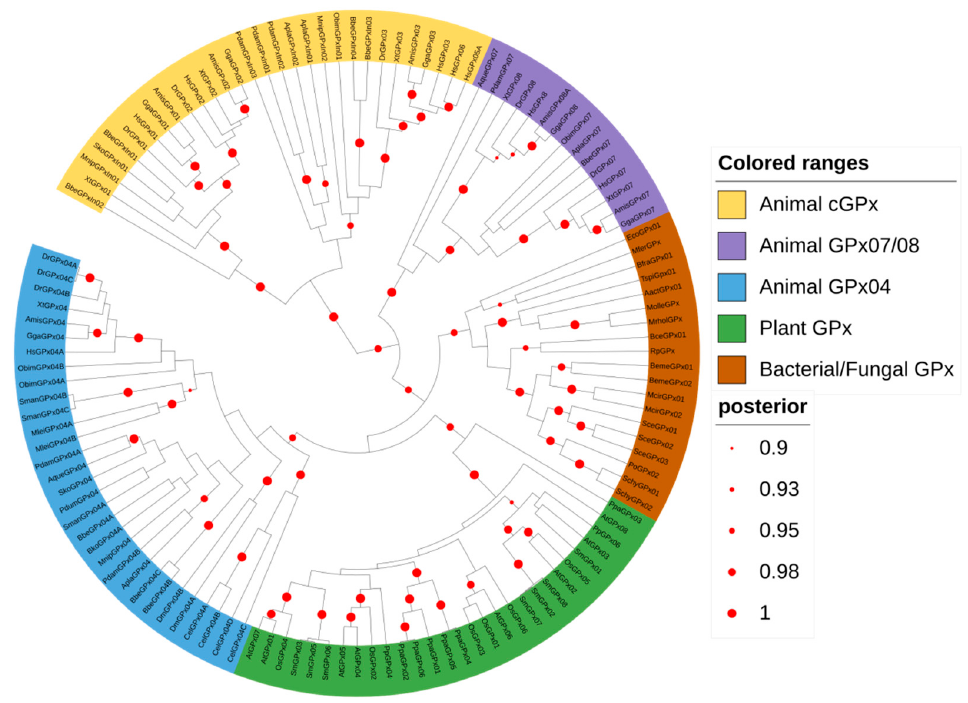
Figure 1. Global GPx tree of representative species from main taxonomic groups. Glutathione peroxidase protein sequences from major phyla of bacteria, fungi, plants, and animals were retrieved and used to reconstruct a phylogenetic tree, using Bayesian inference. A total of 124 sequences were used, and the tree was built on BEAST software, available at CIPRES platform. The posterior probabilities are discriminated according to the figure legend; only values above 0.9 are indicated.